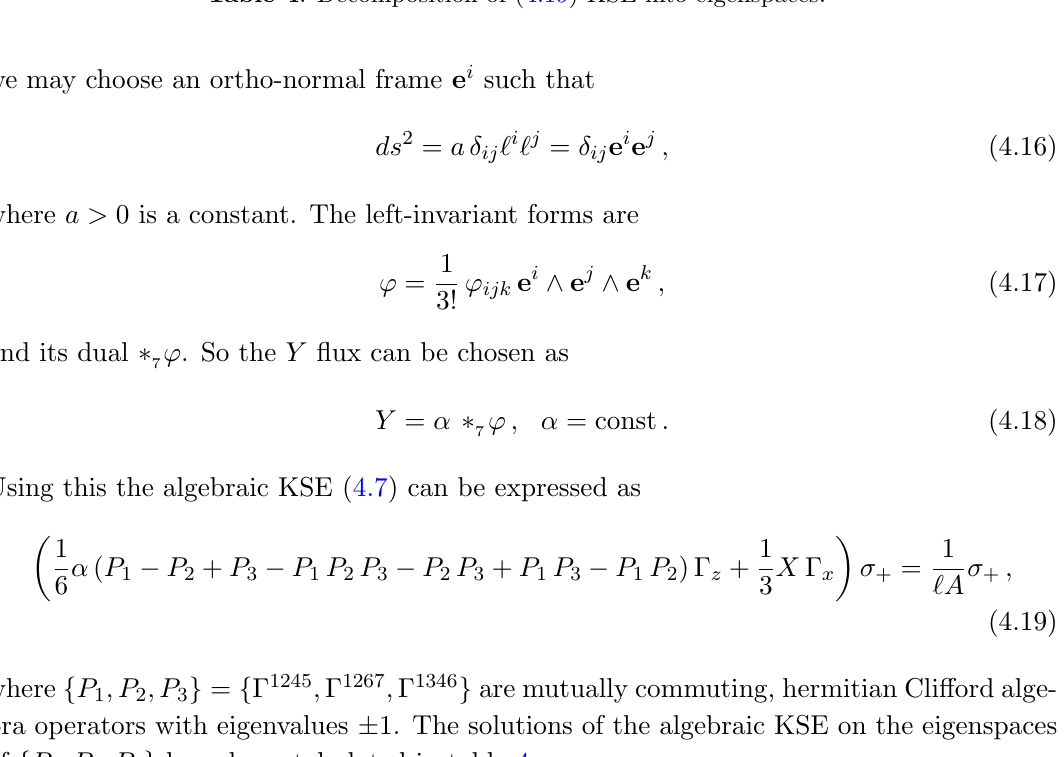
Table 4 . Decomposition of (4.19) KSE into